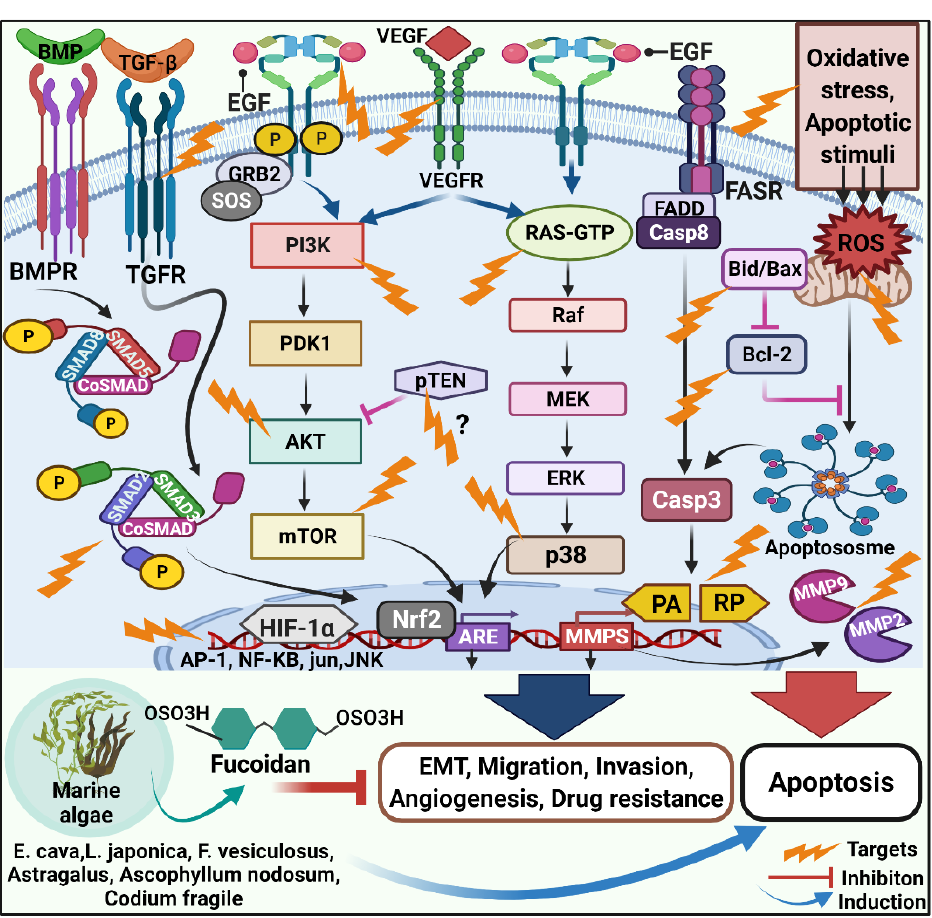
Figure 1. Schematic representation of following signaling pathways and molecules targeted by fucoidan to exert anticancer activities. Fucoidan from marine algae modulates TGF- β, PI3K/Akt/MAPK and extrinsic and intrinsic apoptosis pathways to enhance cytotoxic effects. The aforementioned pathways are deregulated in cancer, resulting in Epithelial-mesenchymal transition (EMT), migration, adhesion, drug resistance and metastasis. Fucoidan enhances antimetastatic effects, induces apoptosis, and serves as a potential marine anticancer